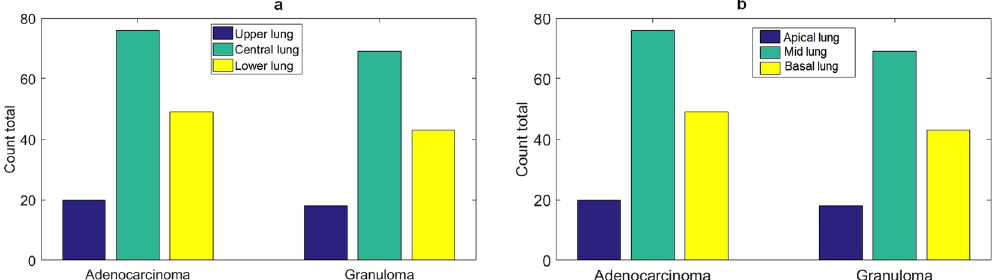
Figure 7. The distribution of the nodules based on ( a ) their position in 2D transverse lung plane which include upper, central and lower lung nodules. ( b ) Their position along z-axis including apical, mid or basal lung